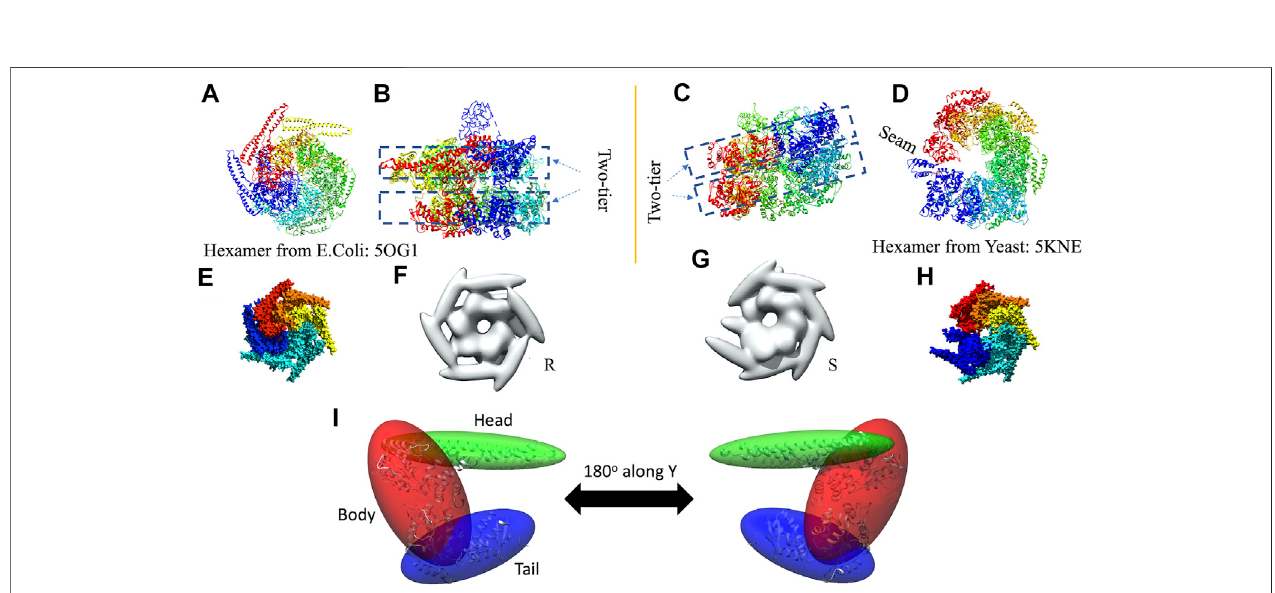
FIGURE2| Hexamericstructuresselectedasinitialmodelsfrom E.coli (A,B) and Yeast (C,D) from5OG1and 5KNE,respectively. In (A) and (D) thestructuresare shown fromthetopandin (B,C) ,aside-viewisshowndescribingtheirtwo-tierstructure.In (D) aseamisshownbetweentwoneighboringchainsdenotedbychains “ A ” (in blue) and “ F ” (in red). The corresponding seam is less prominent in 5OG1 (see Figure 2A ). In the middle row (E – H) , the models with T. thermophilus monomer (from 1QVR, chain A) are shown, and in (I) the 3-kernel model for 1QVR, chain A is shown (with the atomic structure embedded); the head, body, and tail kernels